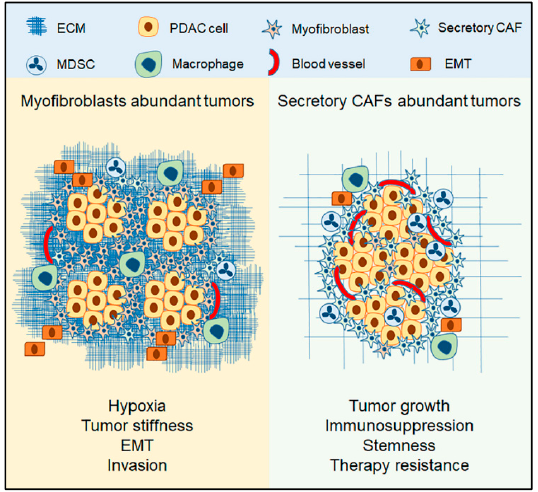
Figure 2. CAFs distribution affects the tumor outcome. Tumors abundant in myofibroblasts are characterized by increased ECM deposition that contributes to hypoxia and tumor stiffness,